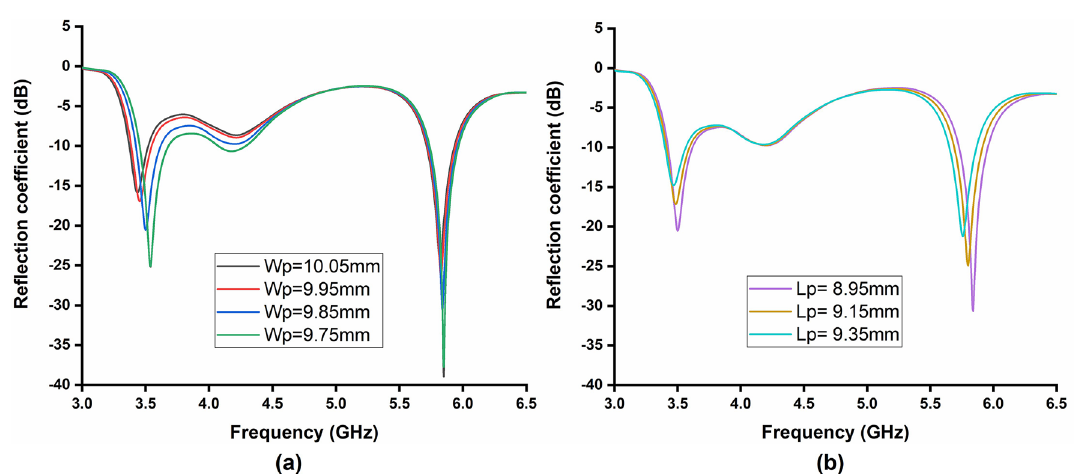
Figure 13. Simulated reflection coefficient of the antenna due to change in length and width of the patch ( a ) effect of Wp; ( b ) effect of